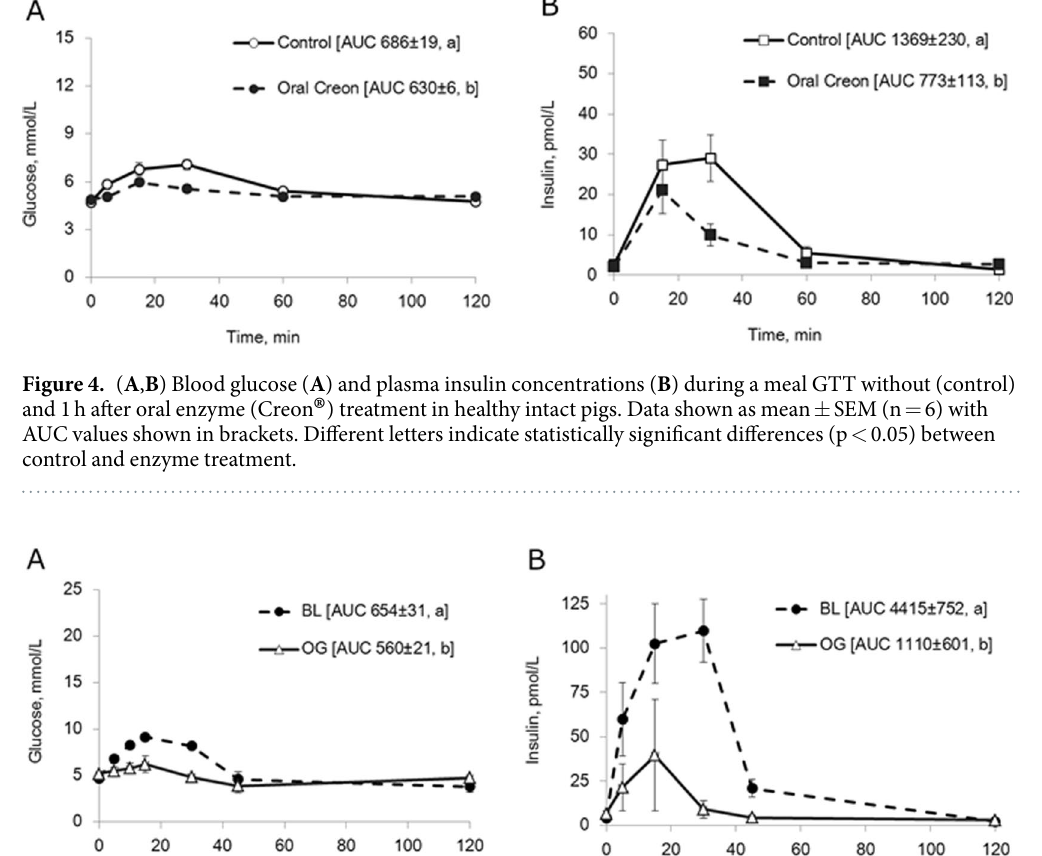
samples collected from the jugular and potal veins from one of the DJB pigs, showed that the amylase/amylase peptide lowering effects on glucose levels seen in the peripheral blood (jugular) (Fig. 8B) were evident directly after intestinal absorption in the visceral portal blood (Fig. 8A).